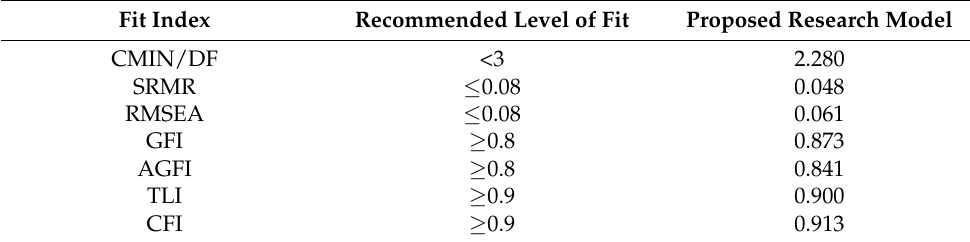
Table 4. Test of hypotheses in the structural model.